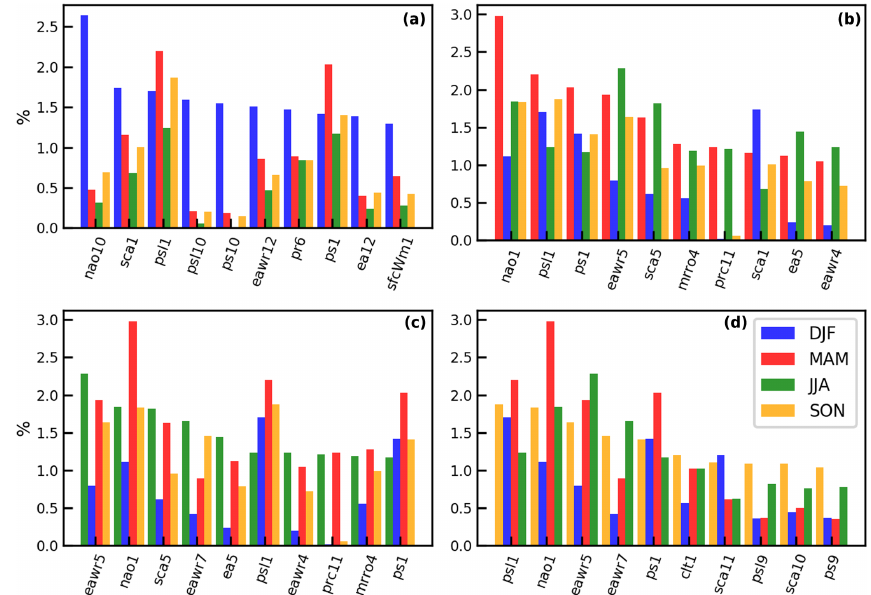
Figure 8. Shapely values for Munich calculated separately for the four seasons and sorted by the maximum contribution in DJF (a) , MAM (b) , JJA (c) and SON (d) for the test dataset; sfcWindmax abbreviated as